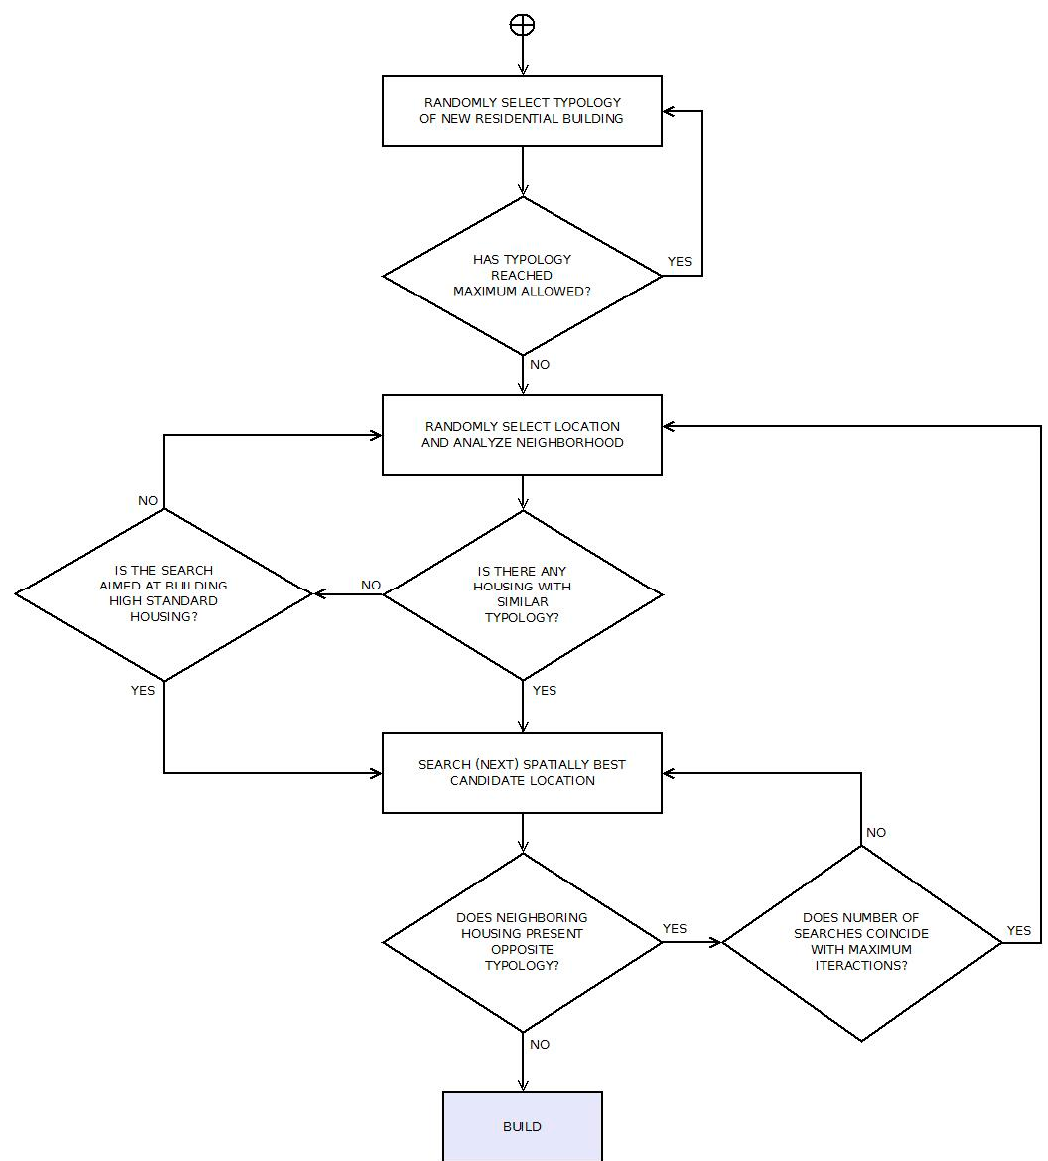
Figure 8. Developer’s decision flow chart.